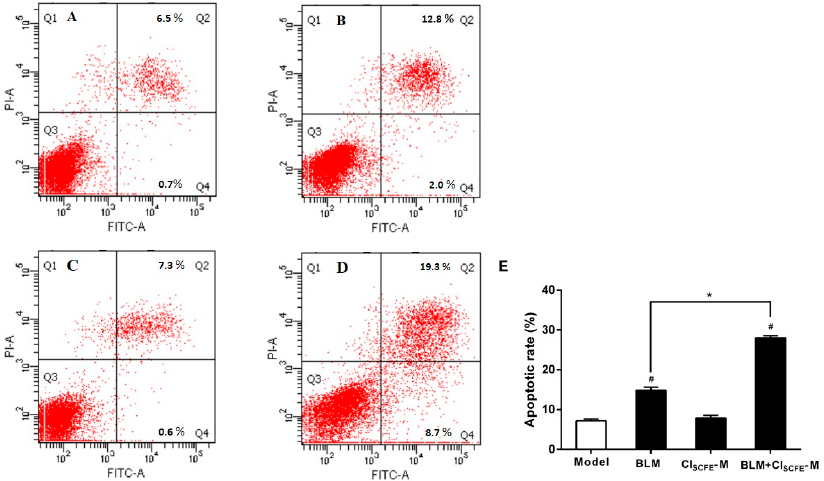
Figure 3. The synergistic effect of BLM with CI SCFE on H22 ascites cell apoptosis induction was analyzed by flow cytometry. ( A ) model group; ( B ) BLM group; ( C ) CI SCFE -M group; ( D ) BLM + CI SCFE -